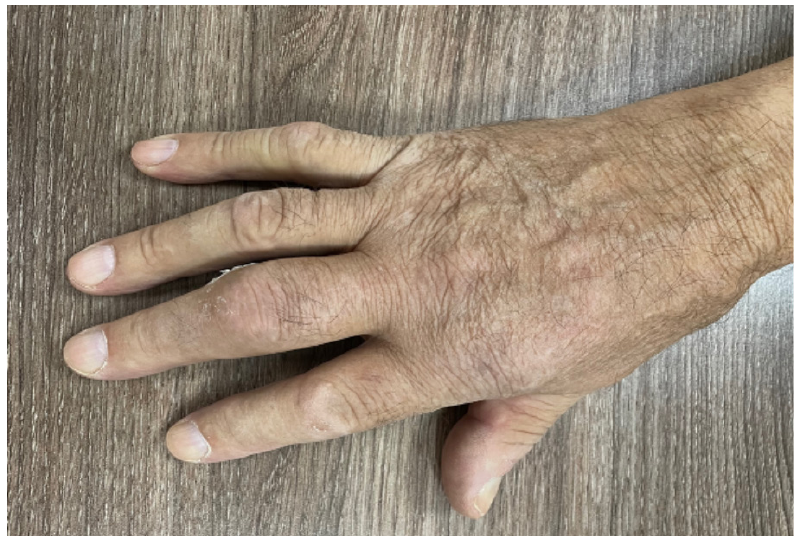
Figure 1. Patient with arthritis and tenosynovitis.